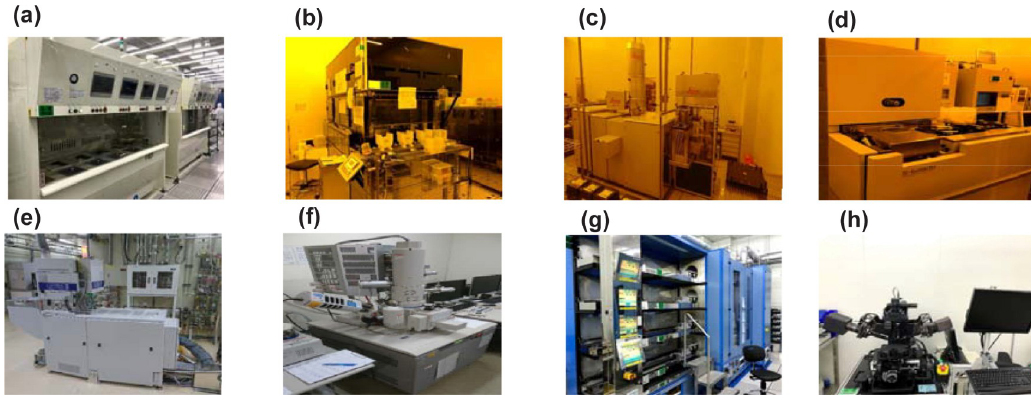
Fig 6. Machines Used. (a) Wet bench (b)Track (c) Leica E-beam (d) In-line SEM (e) Deep RIE (f) SEM (g) Furnace (h) Ellipsometry.